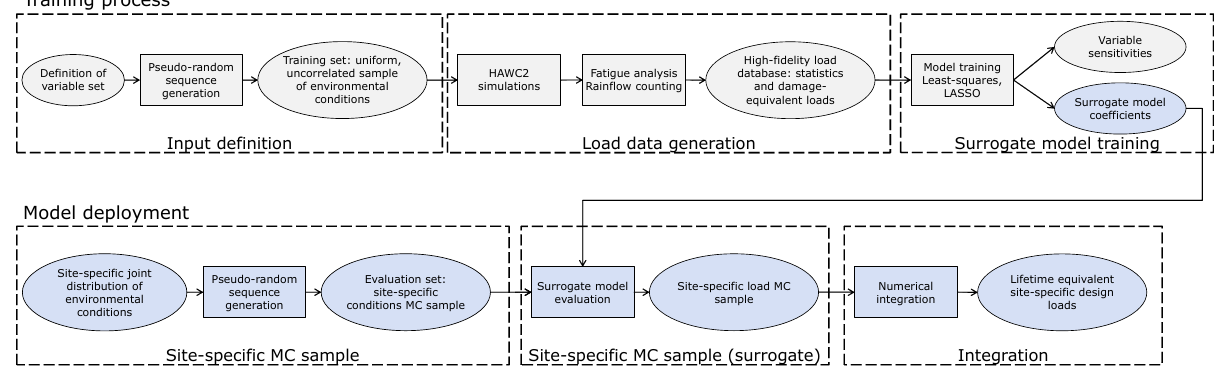
Figure 1. Schematic overview of the site-specific load analysis